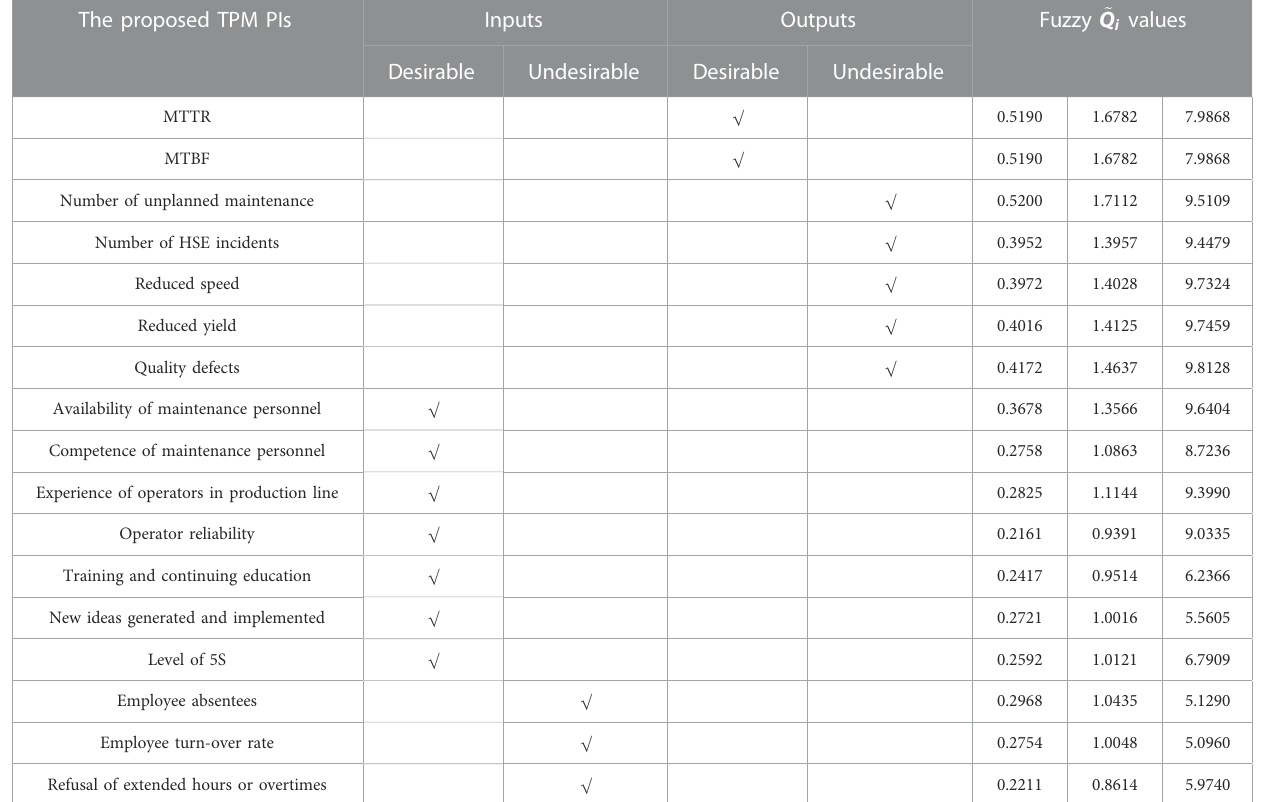
TABLE 7 A list for desirable and undesirable inputs and outputs and their fuzzy ~ Q i